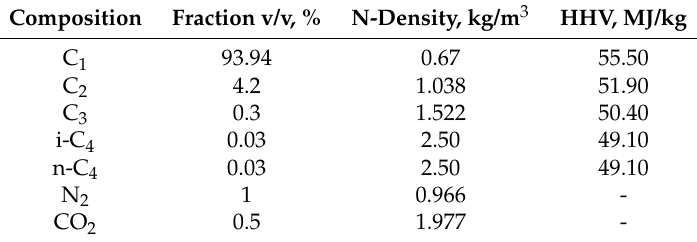
Table 1. Composition properties of natural gas.